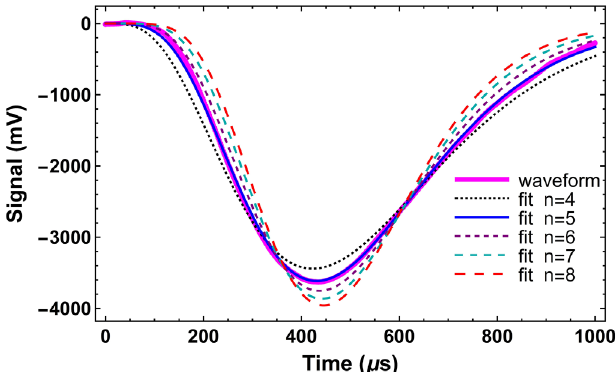
FIG. 28. The unsaturated experimental waveform of beam loss signal for BF 3 monitor and the fitting results with different n values.